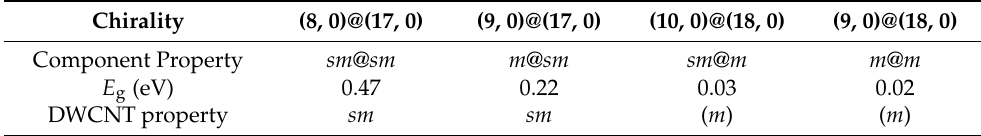
Table 2. Chiralities in the inner@outer CNT format, component properties, the calculated electronic E g and the electrical properties of DWCNTs composed with SWCNTs listed in Table 1.